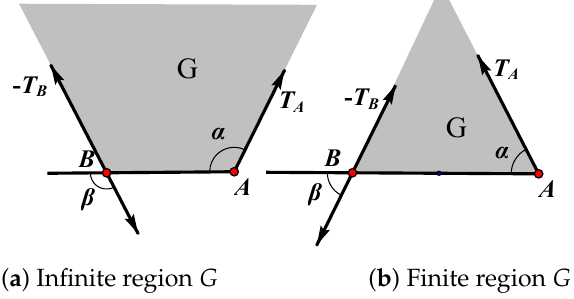
Figure 2. The region G of G 2 Hermite data { A , T A , k A ; B , T B , k B }